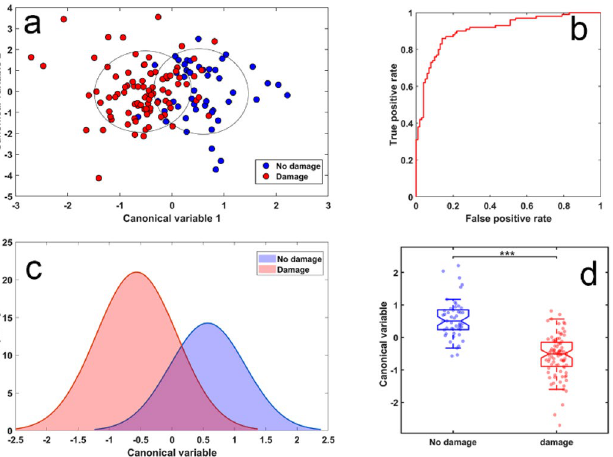
(n = 41 cells) from those with fibrosis (n = 95 cells). Symbols represent individual cells. ( b ) ROC curve for our obtained cell classifier (AUC = 0.90). ( c ) Cell distribution histogram. ( d ) Boxplots corresponding to the cell classifier evaluated in ( b ). Symbols represent individual cells, p <